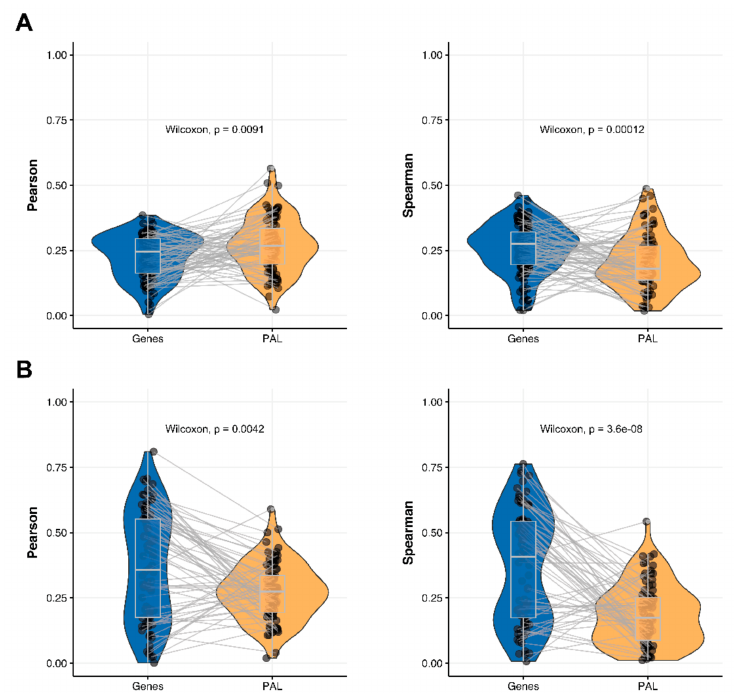
Figure 8. Paired gene-to-gene and PAL-to-PAL correlation between RNA and protein expression levels estimated within Ovarian Serous Cystadenocarcinoma biosamples using Pearson ( left ) and Spearman ( right ) correlation coefficients for ( A ) the total set of genes and molecular pathways; ( B ) the set of drug target genes and molecular pathways